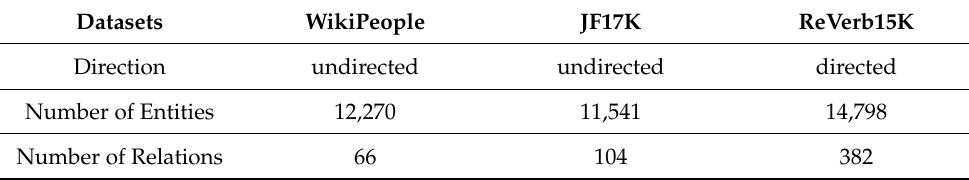
Table 3. Statistics of the hypergraph datasets used in the experiments. Datasets WikiPeople JF17K ReVerb15K Direction undirected undirected directed Number of Entities 12,270 11,541 14,798 Number of Relations 66 104